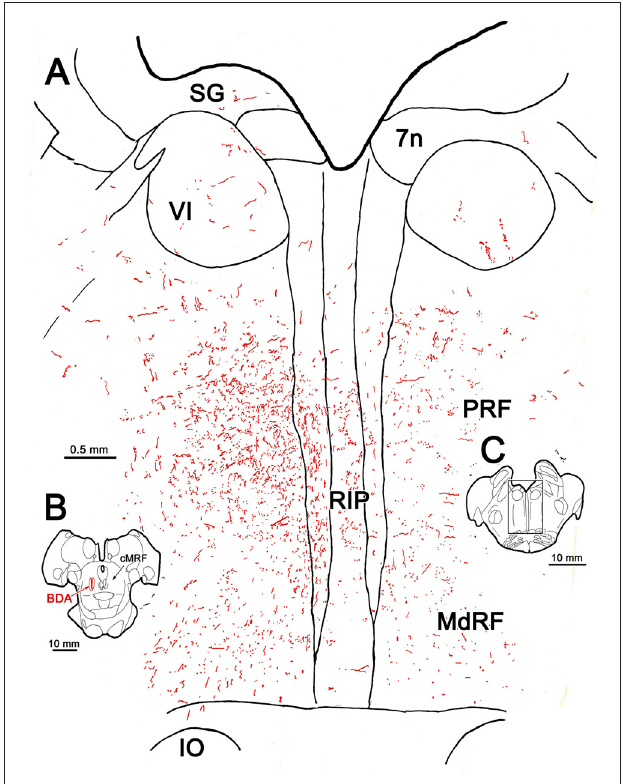
FIGURE 2 | BDA labeled reticuloreticular axons at the level of the abducens nucleus. The pattern of reticuloreticular axons (lines) and terminals (stipple) is illustrated for the region shown by a box in (C) at higher magnification in (A) . The center of the BDA injection within the cMRF that produced the labeling is shown in (B) . Note the ipsilateral predominance of the terminal labeling in the pontine reticular formation (PRF) and medullary reticular formation (MdRF).